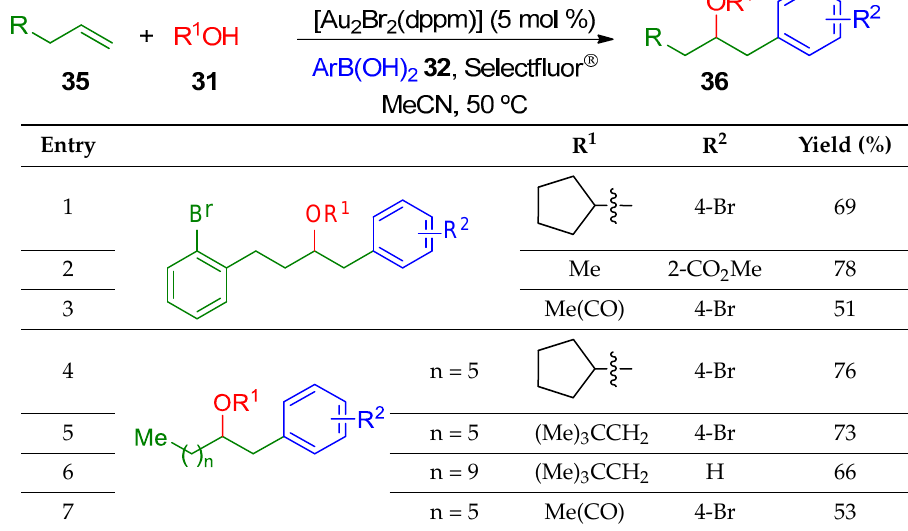
Table 1. Alkoxy- and acyloxyarylation using different alcohols 31